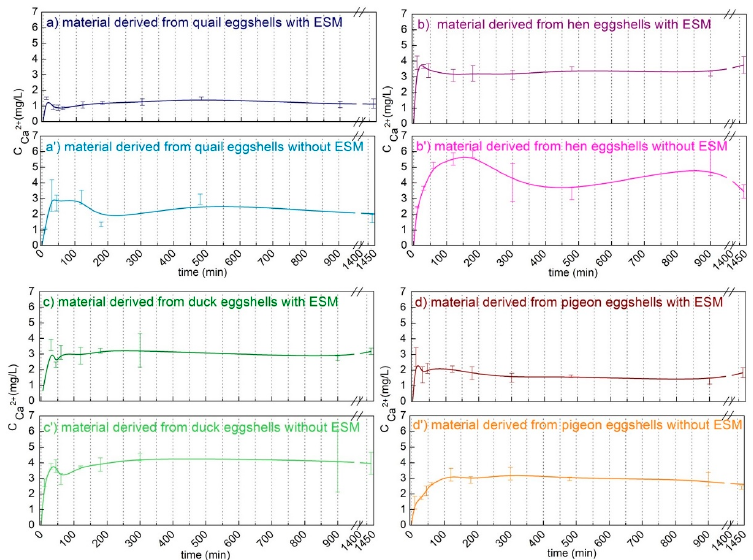
Figure 6. Calcium ions release profiles in the PBS buffer of the materials derived from different poultry species eggshells with ( a – d ) and without ( a’ – d’ ) an eggshell membrane (EMS).